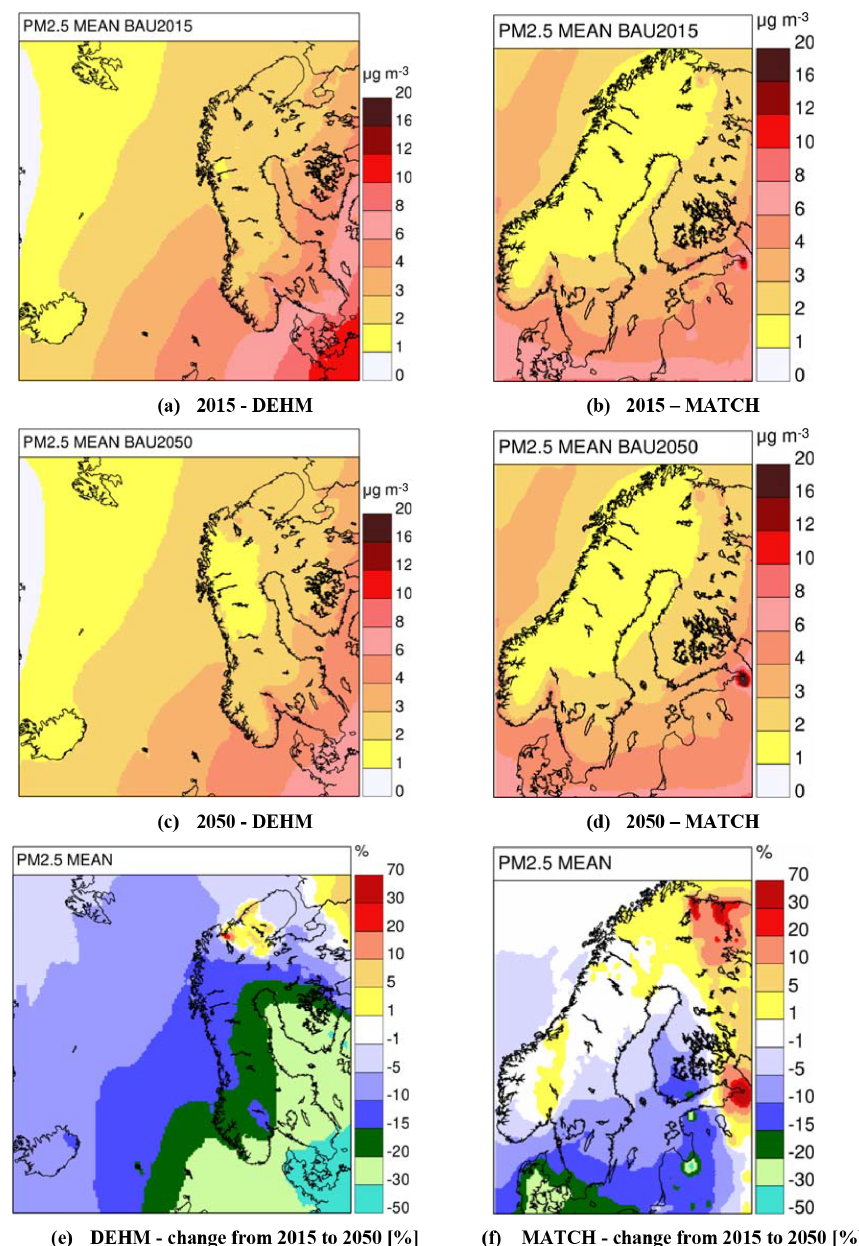
Figure 4. The annual mean surface PM 2 . 5 concentration [µgm − 3 ] for 2015, 2050 and the percentage change as simulated by the two models.